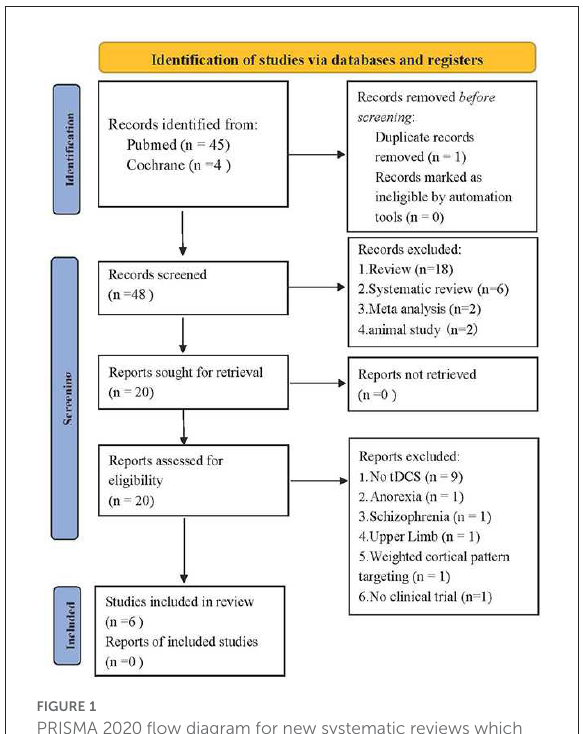
FIGURE1 PRISMA 2020 flow diagram for new systematic reviews which included searches of databases and registers